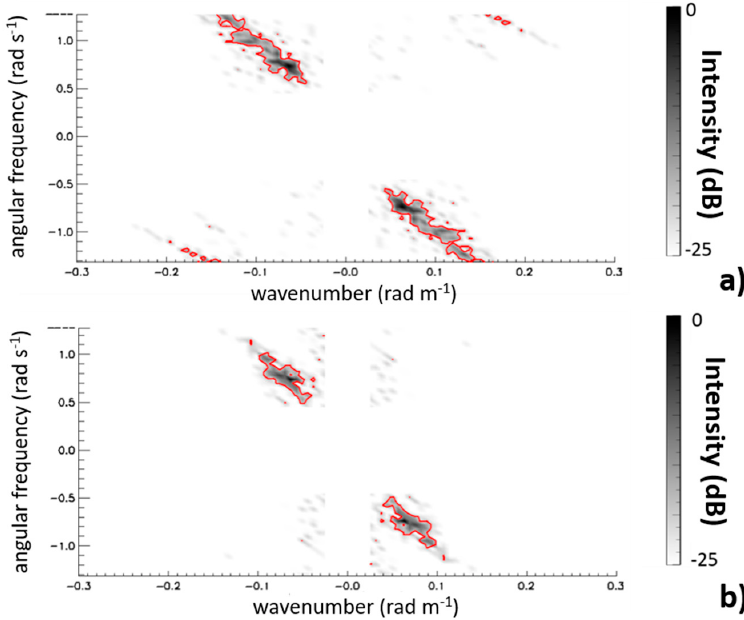
Figure 4. Sections of the spectrum of the radar signal achieved for short ( a ) and medium ( b ) mode. The plot corresponds to a transect in the ω -k spectral domain along the peak wave direction. Red edge indicates the region where the radar spectrum intensity is larger than − 20 dB of the maximum value.